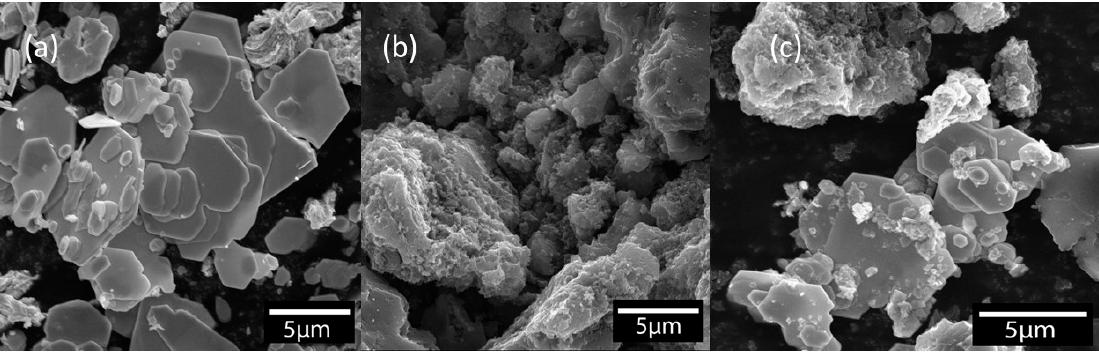
Figure 1. SEM images of ( a ) pure WS 2 , ( b ) AC, and ( c ) WS 2 -AC (1:2)